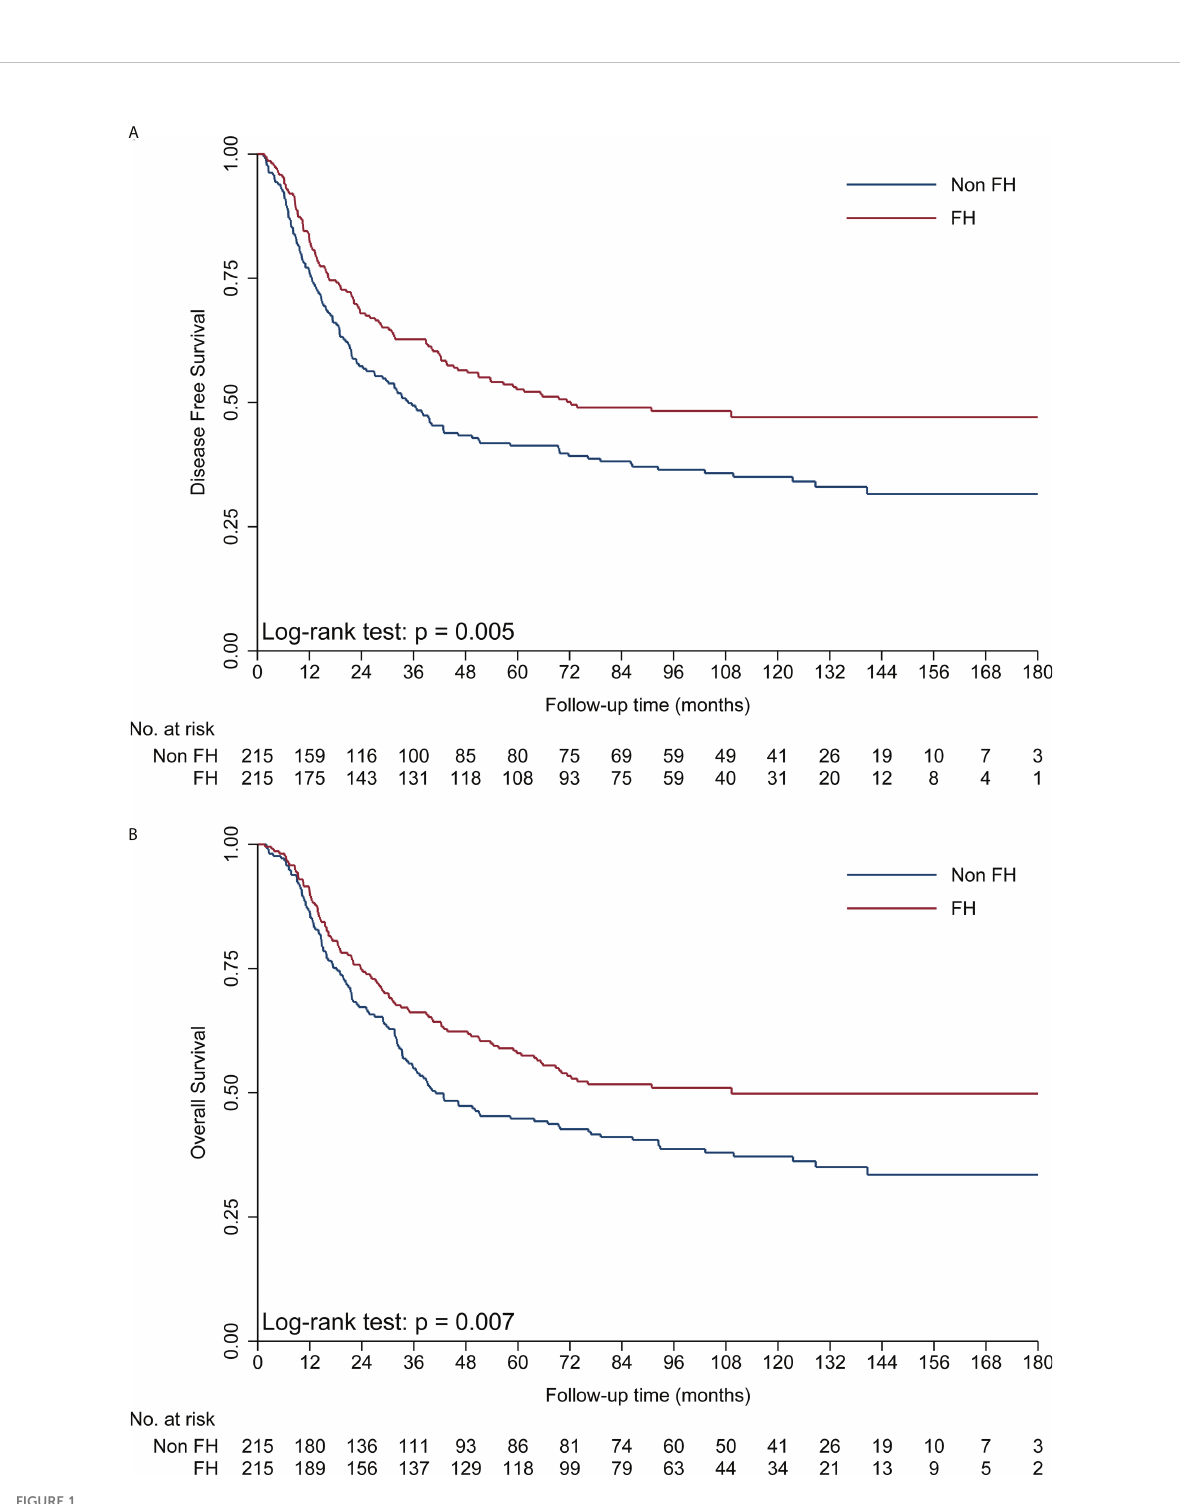
FIGURE 1 Kaplan – Meier curves showing a signi fi cant difference in DFS (A) and OS (B) in the FH and non-FH groups. DFS, disease-free survival; FH, family history of cancer; OS, overall